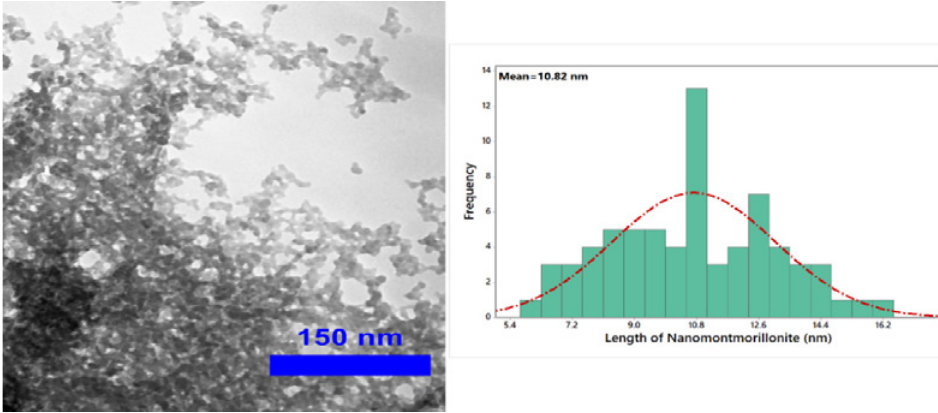
Fig. 3. TEM image and histogram of the length of montmorillonite Figure 3. TEM image and histogram of the length of montmorillonite nanoparticles.